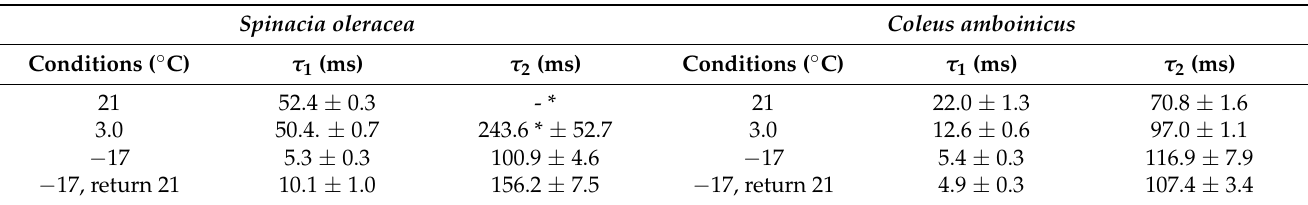
Figure 8. Photon lifetime curves acquired from York DF Photon Counting Device for chill stressed: ( a ) Spinacia oleracea and ( b ) Coleus amboinicus. The plants were subjected to temperatures 21 ◦ C (red), 3 ◦ C (green), − 17 ◦ C (blue), − 17 ◦ C returned to ambient (cyan). Black line indicates the instrument response function. Table 2. Lifetime values of chill stressed Spinacia oleracea and Coleus amboinicus .